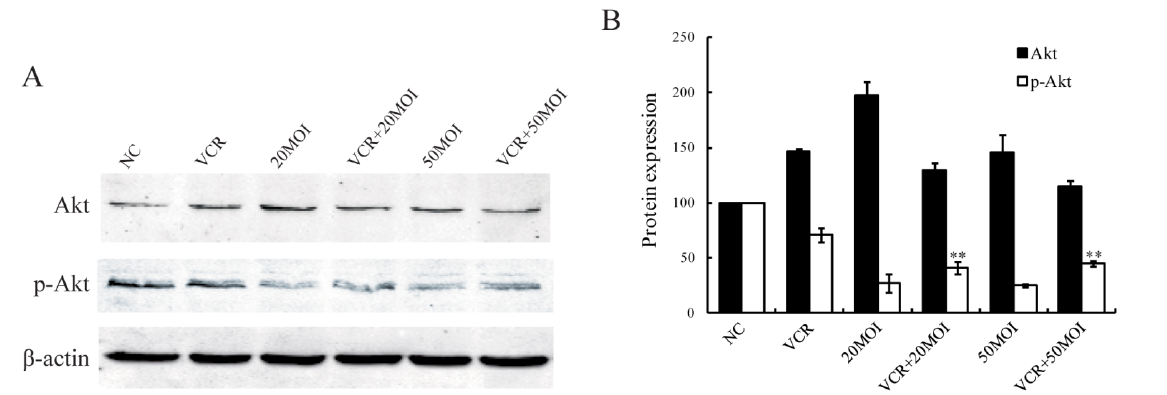
Figure 5. The expression patterns of Akt and phospho-Akt in HXO-RB different treatments for 48 h. ( A ) The proteins were analyzed by immunoblot with specific antibodies; ( B ) Average band density of quantified Akt and phospho-Akt protein after normalization to the internal control β -actin. Protein expression of Akt and phospho-Akt in the NC group was arbitrarily set as 100. ** p < 0.01 relative to phospho-Akt protein expression in the 5 nM VCR-treated group. NC (negative control): treatment with